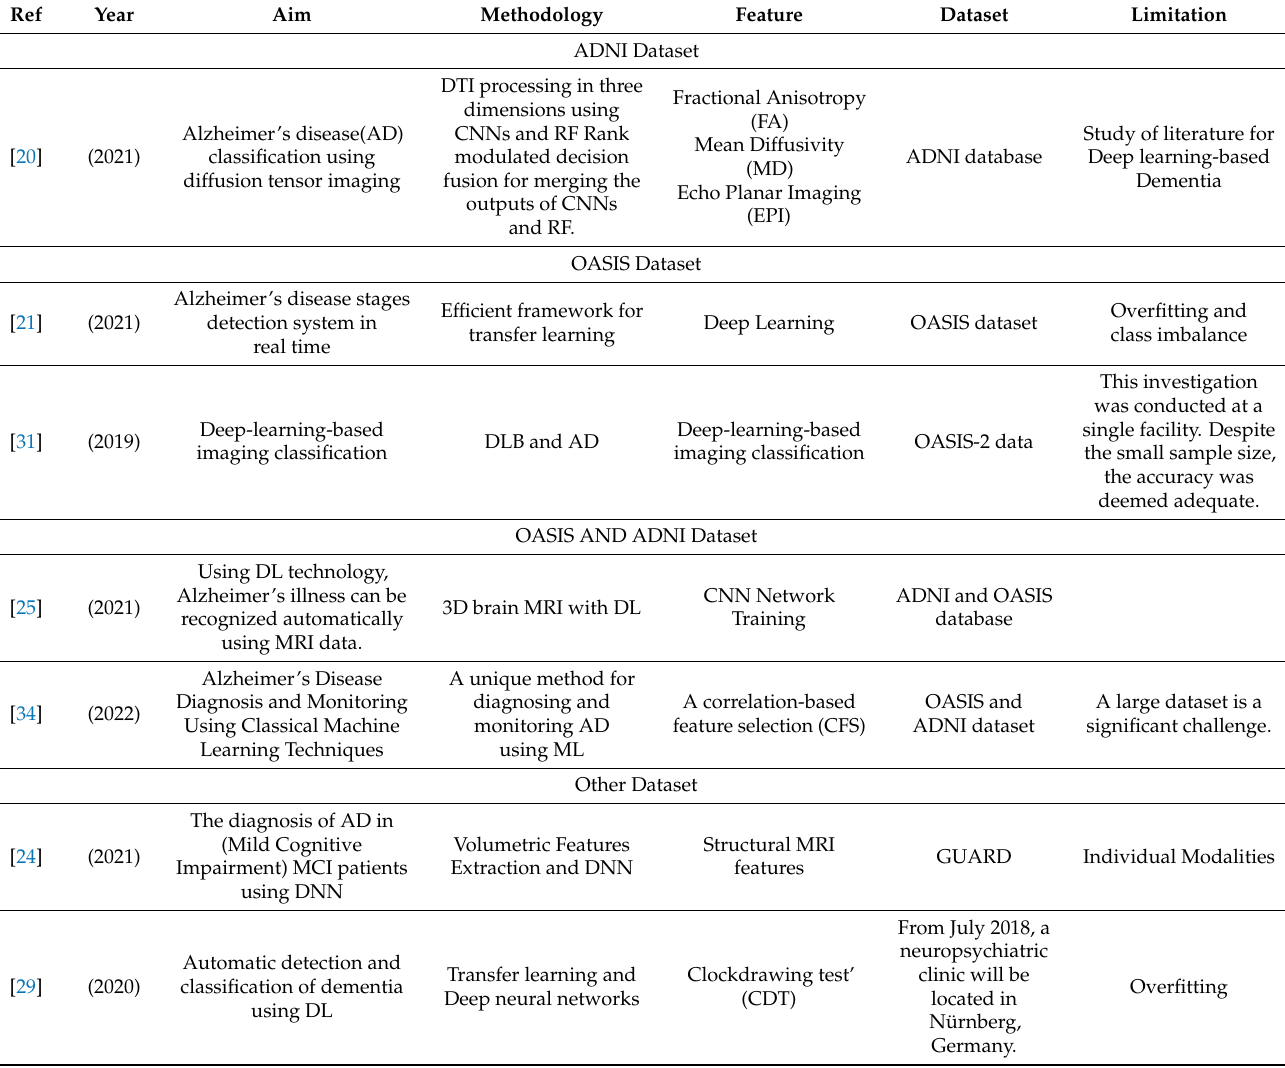
Table 1. Study of literature for Deep learning-based